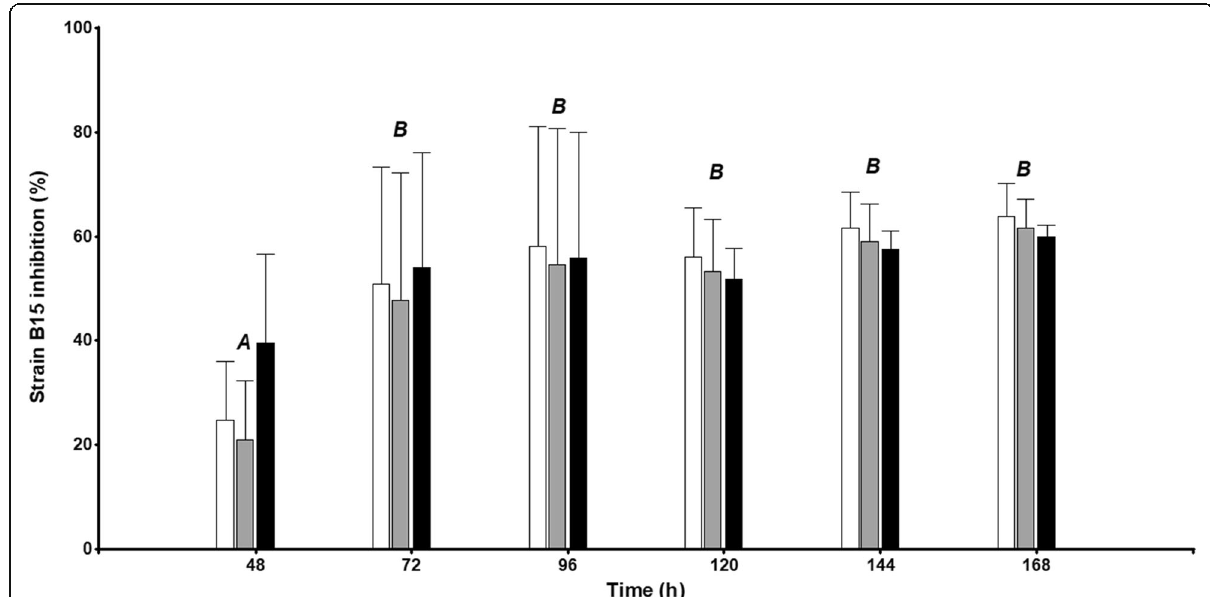
Fig. 3 Percent inhibition of Botrytis cinerea strain B 15 caused by three entomopathogenic fungi . Error bars represent the standard deviation for three replicates. Different letters indicate significant differences among the time stages (LSD Fisher 0.05). Control treatments (not shown) represent 0% inhibition, and they were statistically different from the three fungal treatments. Columns represent inhibition percentage given by CEP413 (white), CEP589 (gray), and CEP591